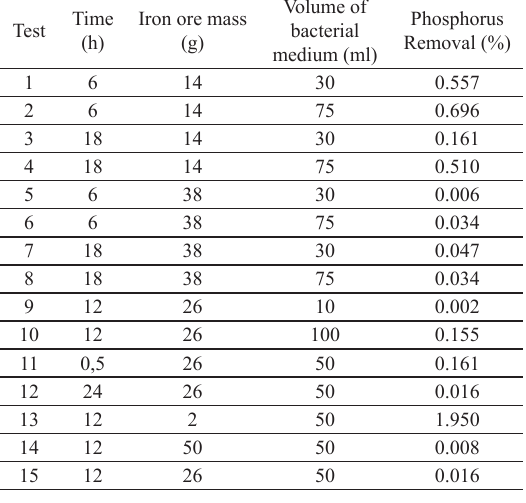
Table 4. Levels used in factorial planning and phosphorus removal